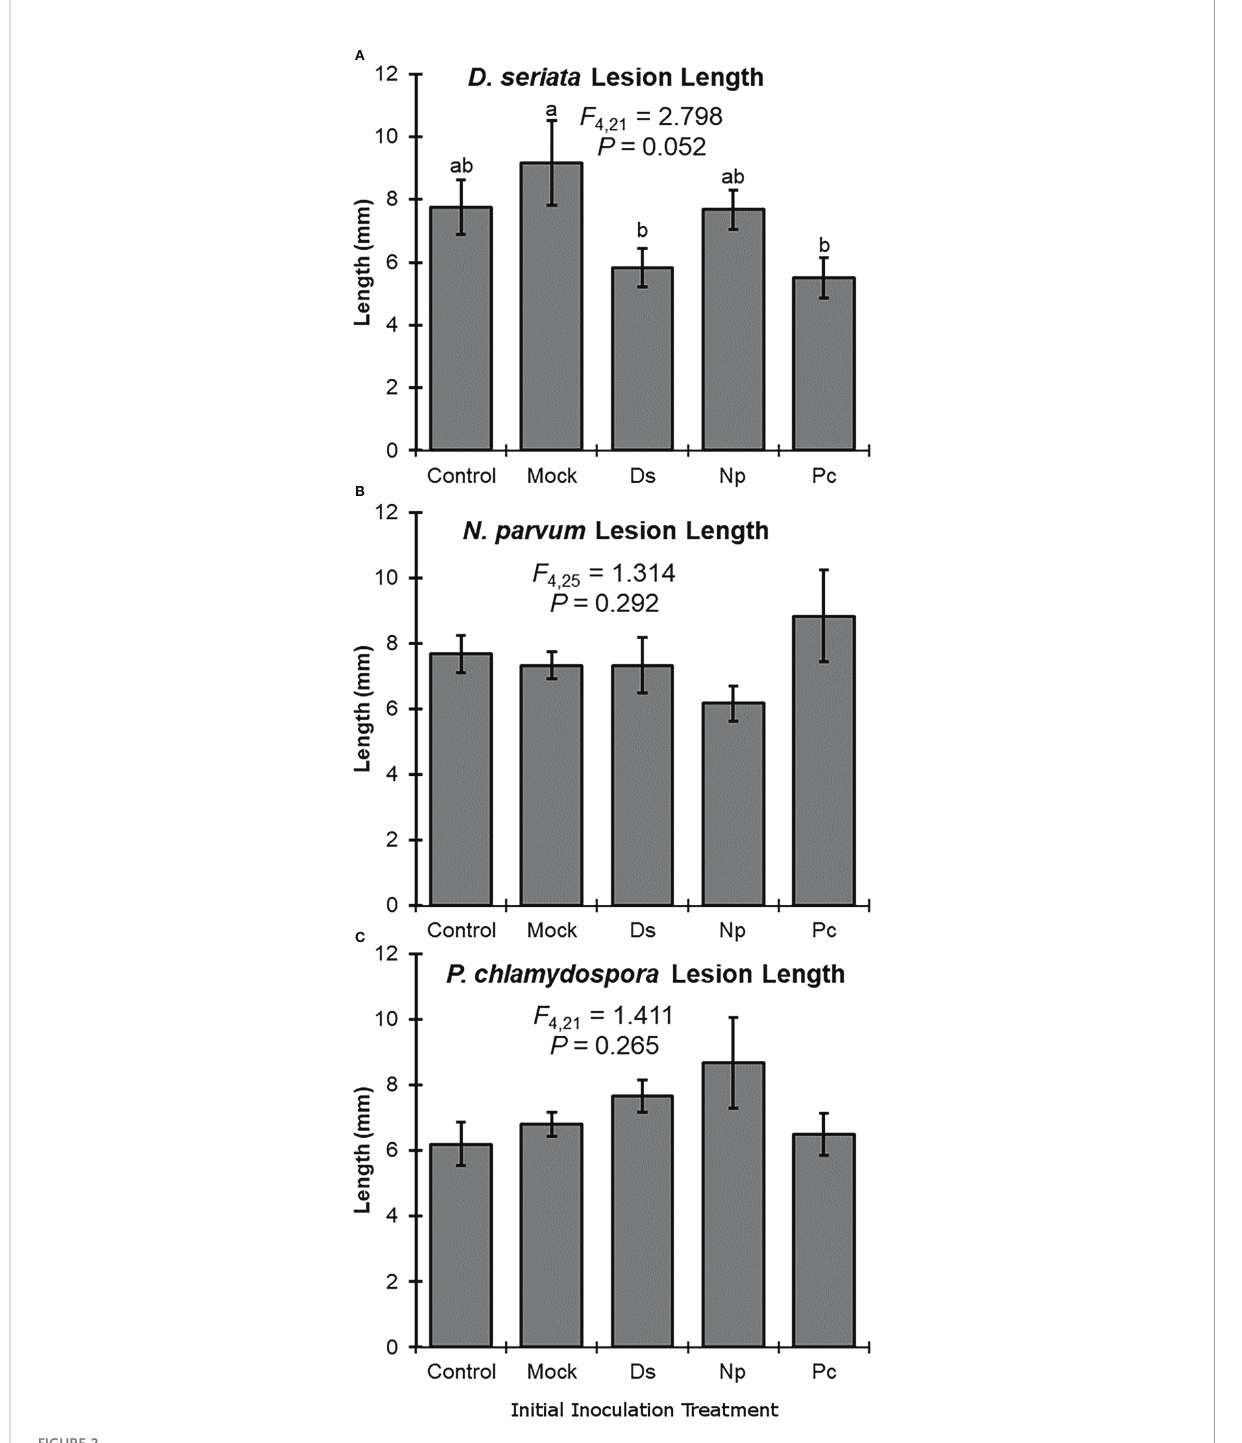
FIGURE 2 Mean lesion lengths (± SE) after the second inoculation with: (A) Diplodia seriata , (B) Neofusicoccum parvum , or (C) Phaeomoniella chlamydospora . Differences among initial inoculation treatments are noted with different letters (statistical differences by least signi fi cant differences tests). Initial inoculation treatments are as follows (on the X axis): Control, NINW; Mock, NIW; Ds, Diplodia seriata ; Np, Neofusicoccum parvum ; Pc, Phaeomoniella chlamydospora